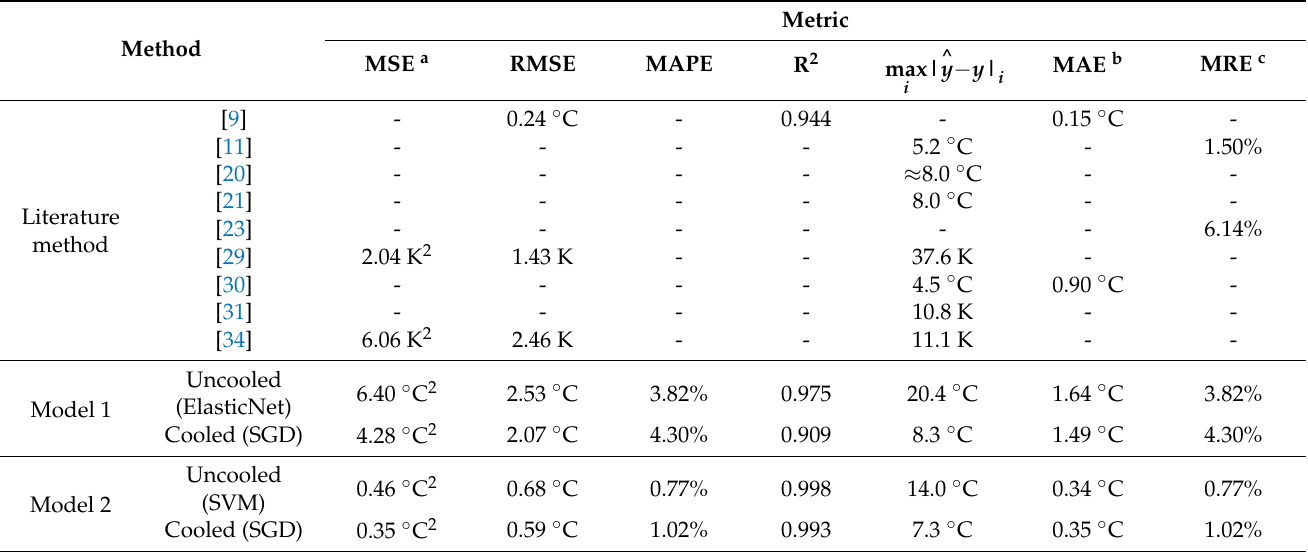
Table 3. Comparison of estimation results with methods reported in the